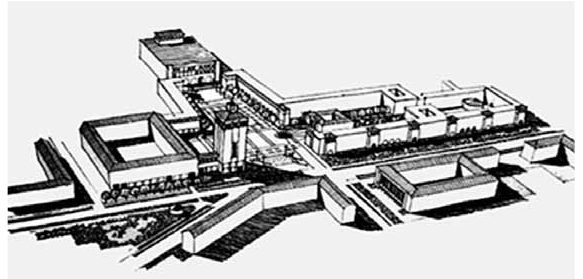
fig. 5. Competition entry for the square in front of the Diósgyőr factory, one of the biggest Hungarian works of heavy industry. It features an asymmetrically placed vertical element near the entrance